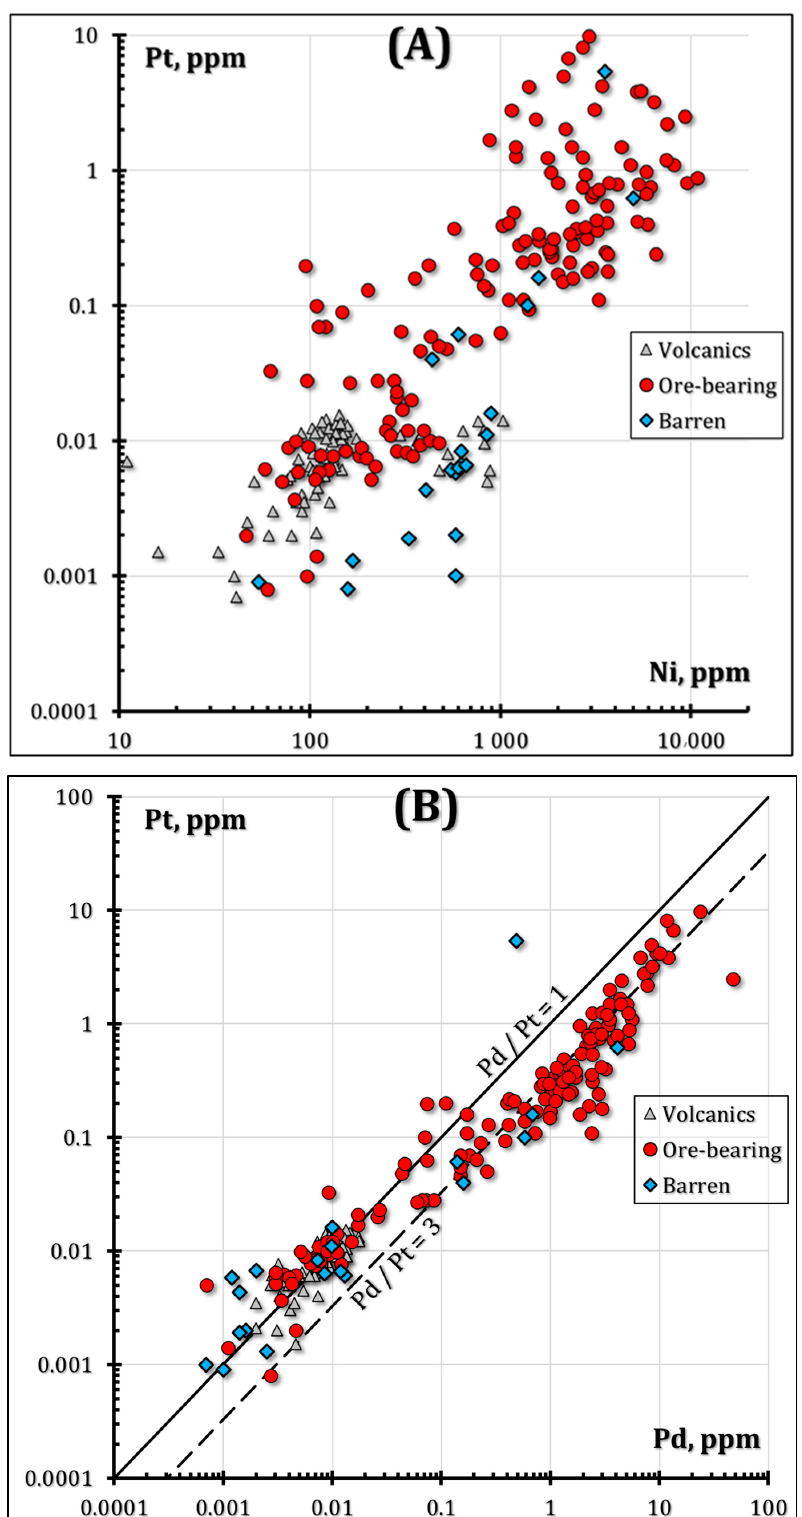
Figure 11. Ni and Pt ( A ) as well as Pt and Pd ( B ) contents correlate in ore-bearing and barren intrusive rocks. There are no such correlations in volcanics; however, their datapoints coincide with the trend of the intrusive rocks in the low contents part. Data from [27–29,33,34,46]. Note the increase in the Pd/Pt ratio as their concentrations in the rocks increase.